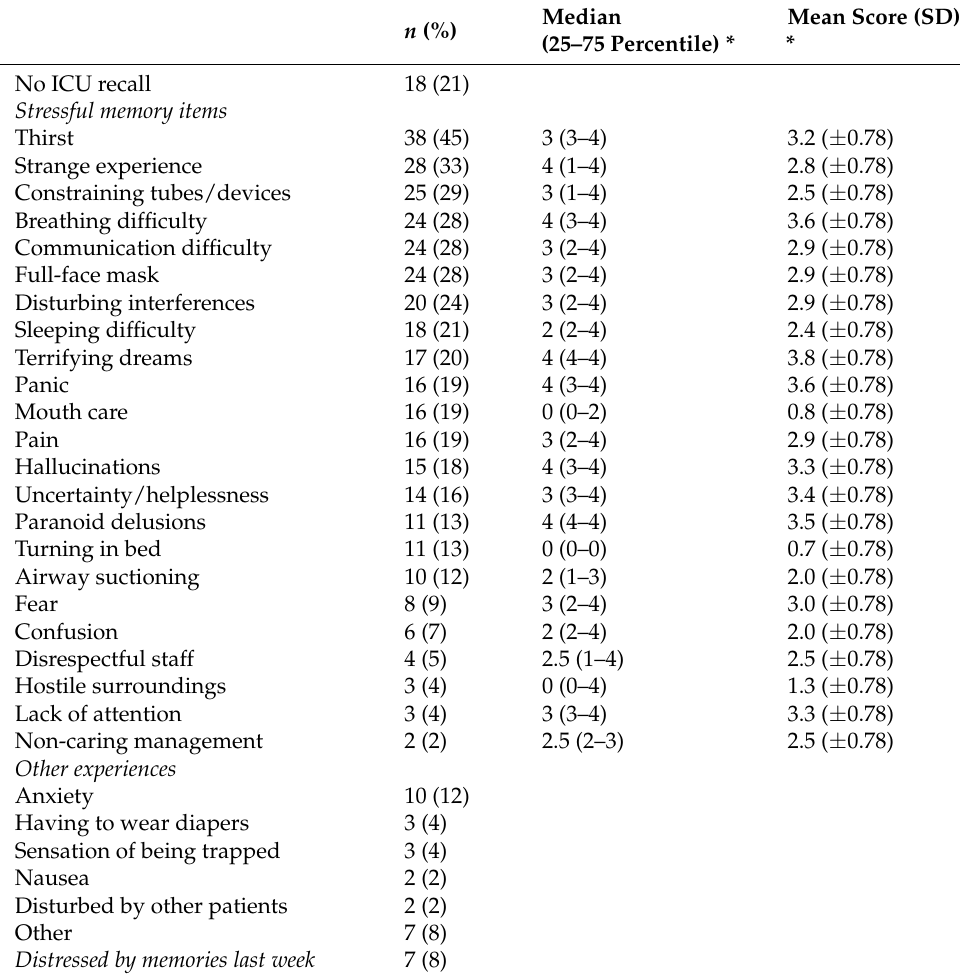
Table 1. Phase one. Frequency and rating of stressful memories in intensive care patients by use of the preliminary 23-item checklist with 5 response categories (N =